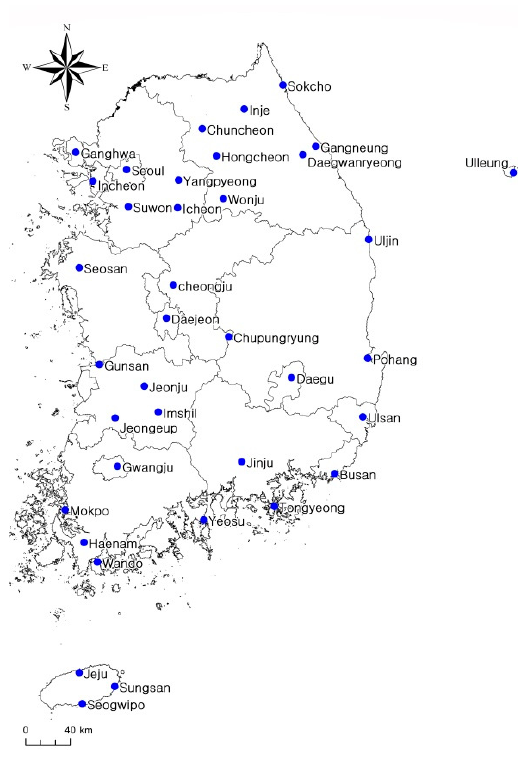
Figure 2. S tations for the study. Figure 2. Stations for the